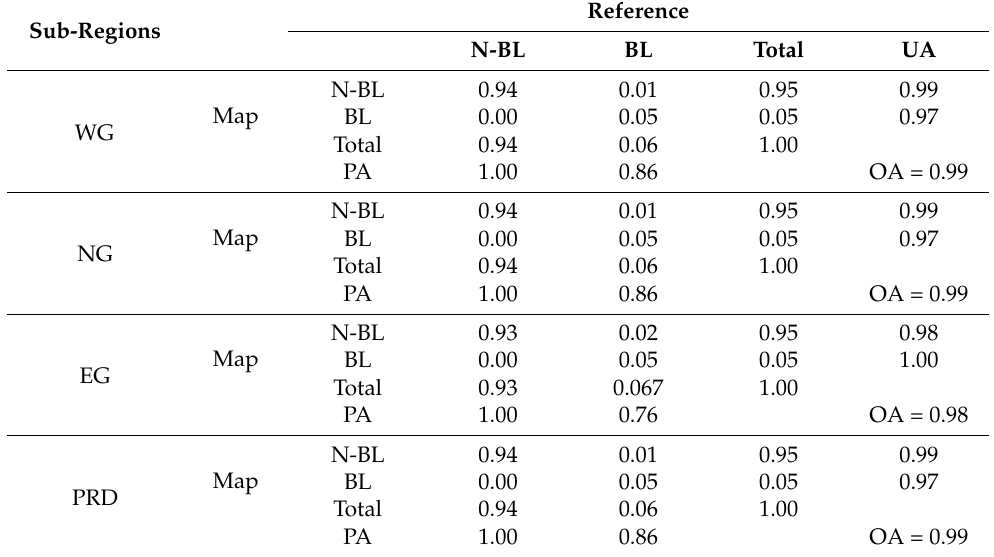
Table 3. Error matrix with cell entries expressed in terms of proportion of area and accuracies based on Res-UNet++ in 2020. The vertical axis represents the truth, and the horizontal axis represents the results of mapping, which are divided into four sub-regions for statistics (WG–West Guangdong, NG–North Guangdong, EG–East Guangdong, PRD–Pearl River